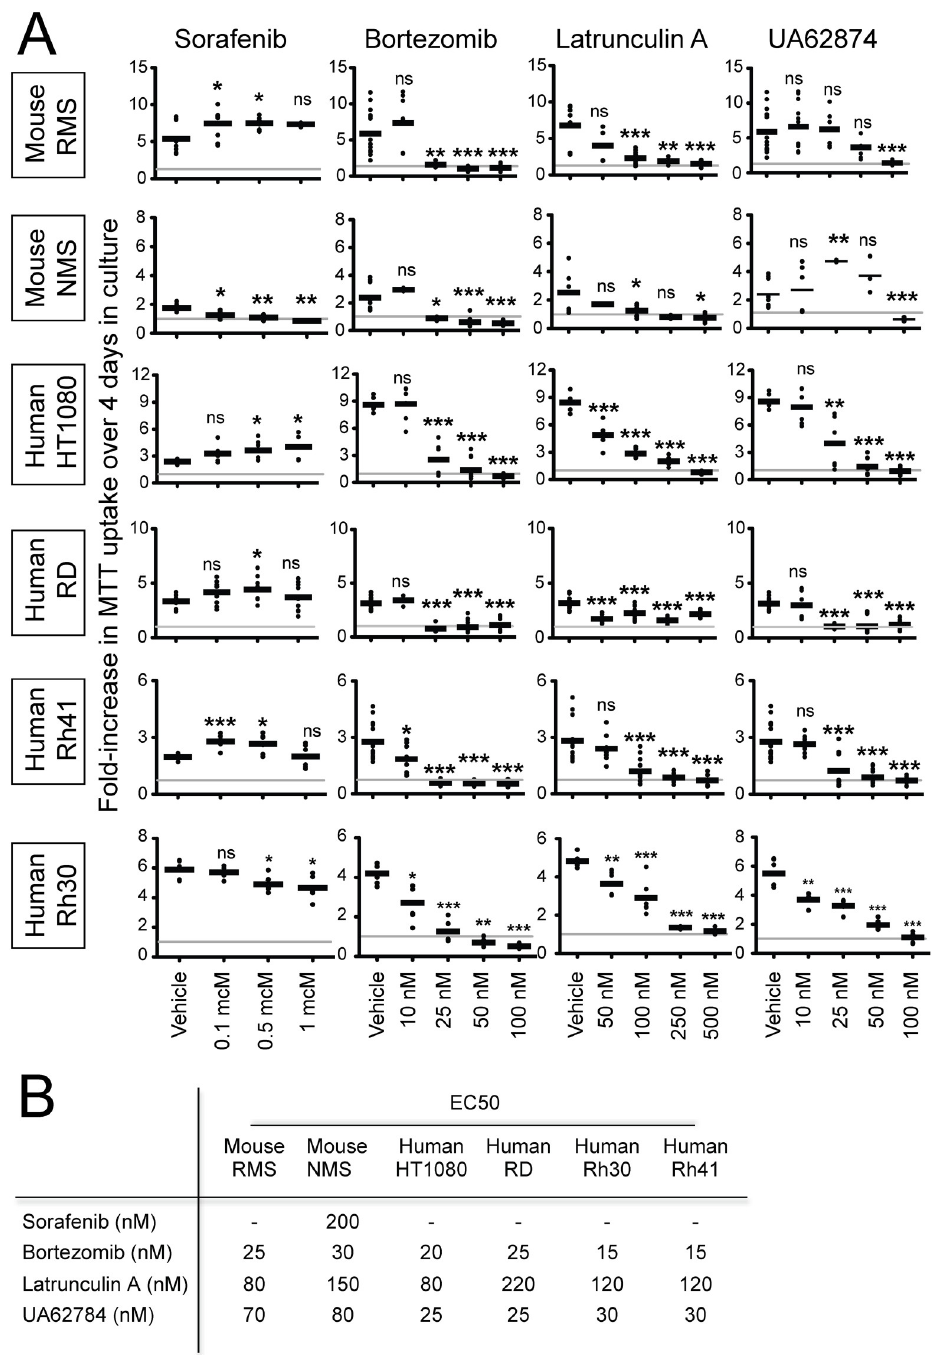
Fig 3. Chemical inhibition of mouse and human sarcoma cell growth in vitro . (A) Bortezomib, Latrunculin A, and UA62874, previously reported to modulate cellular functions of UBE2C, HAS2 and CENPE, respectively, reduced proliferation of a Kras;CDKN2A null mouse sarcoma cell line with myogenic differentiation (mouse RMS), a Kras; CDKN2A null undifferentiated, non-myogenic mouse sarcoma cell line (mouse NMS), the human fibrosarcoma cell line HT1080, the human embryonal RMS cell line RD (PAX3/7:FOXO1-negative) and the human alveolar RMS cell lines Rh30 and Rh41 (PAX3/7:FOXO1-positive). Sorafenib increased growth of the mouse RMS cell line, HT1080, RD and Rh41 (mean +/- SD of 6 technical replicates obtained in 3 independent experiments are presented; ns p � 0.05, � p < 0.05, �� p < 0.01, ��� p < 0.001, as determined by T-tests compared to vehicle-treated cells). (B) Estimated EC50 concentrations ranged between 15–30 nM for Bortezomib, 80–150 nM for Latrunculin A and 25–80 nM for UA62784 (EC50 concentrations were calculated using graphpad). Please see also S3 Fig.